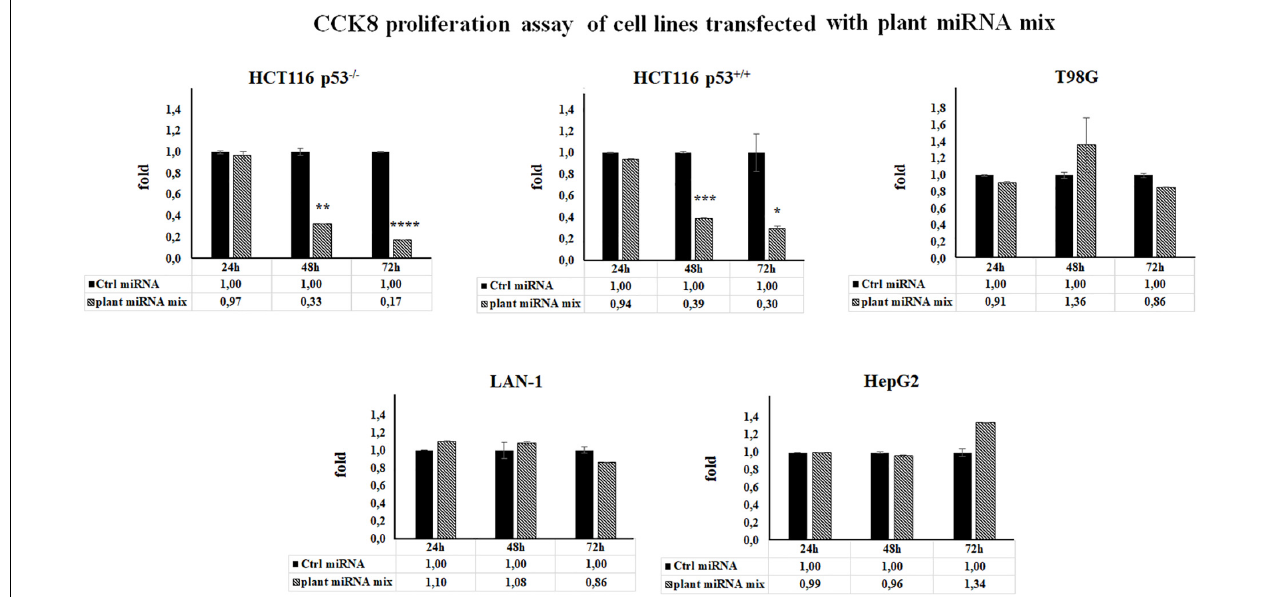
FIGURE 2 | Plant microRNAs (miRNAs) are able to modulate human cell proliferation rate. Cell proliferation was measured by Cell Counting Kit-8 (CCK-8) assay in cell lines transfected for 24, 48, and 72 h with control miRNA or with a mix of the seven selected plant miRNAs (15 µ M f.c. for each; gma-miR-160, gma-miR-4995, gma-miR-4368, gma-miR-5677, gma-miR-4351, zma-miR-172, and mtr-miR-5754). Data presented show the average of three independent experiments with standard deviation (* p < 0.05; ** p < 0.005; *** p < 0.0005, and **** p <